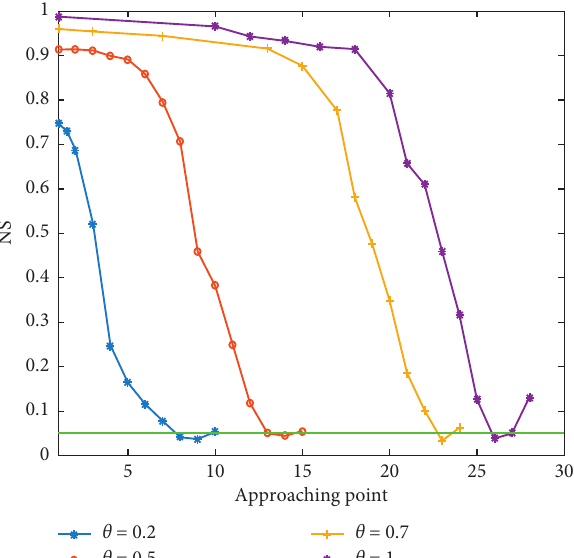
Figure 2: Calibration procedure for Model 3.